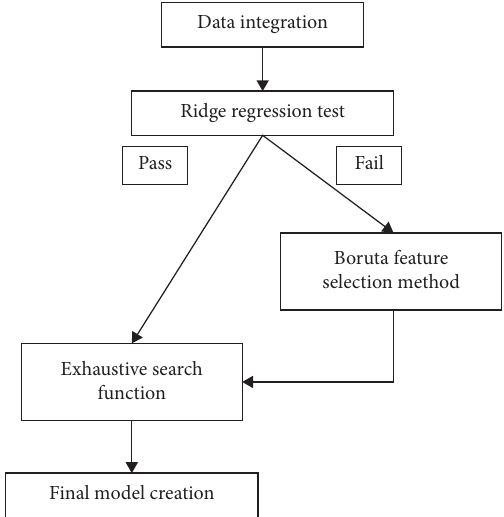
Figure 2: Methodological